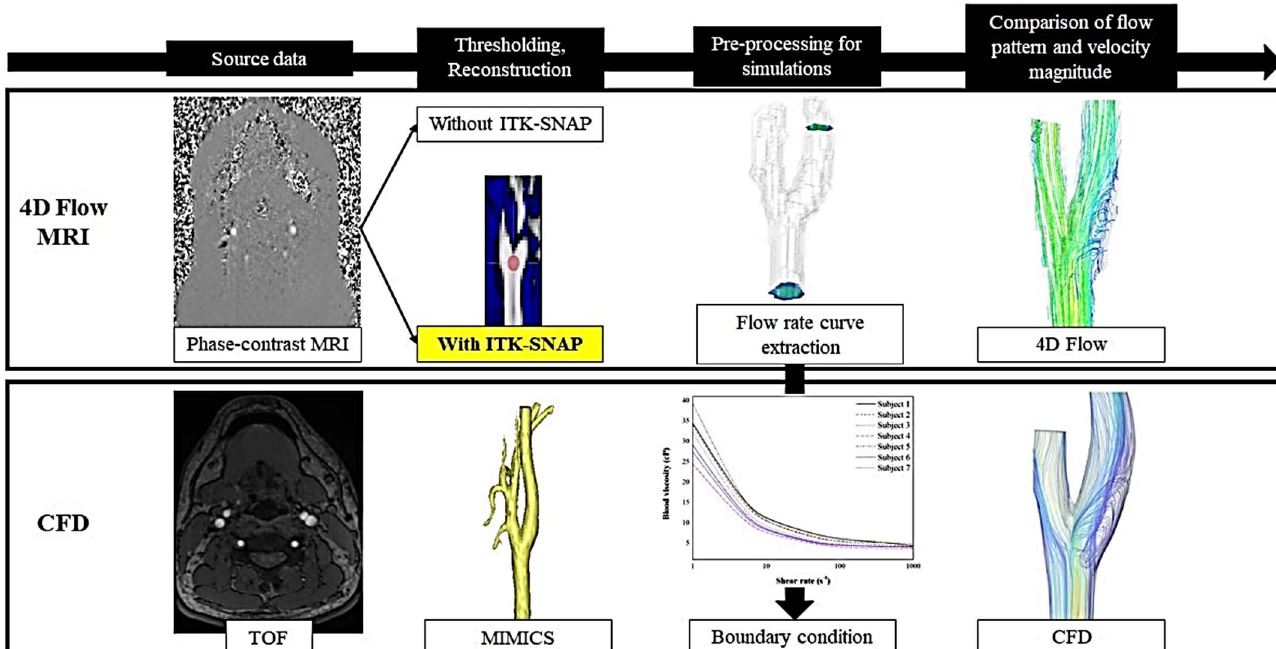
Figure 1. Flow chart of the hemodynamic analysis process of 4D flow MRI ( first row ) and CFD ( second row ). Segmentation using ITK-SNAP was included in the 4D flow MRI workflow.